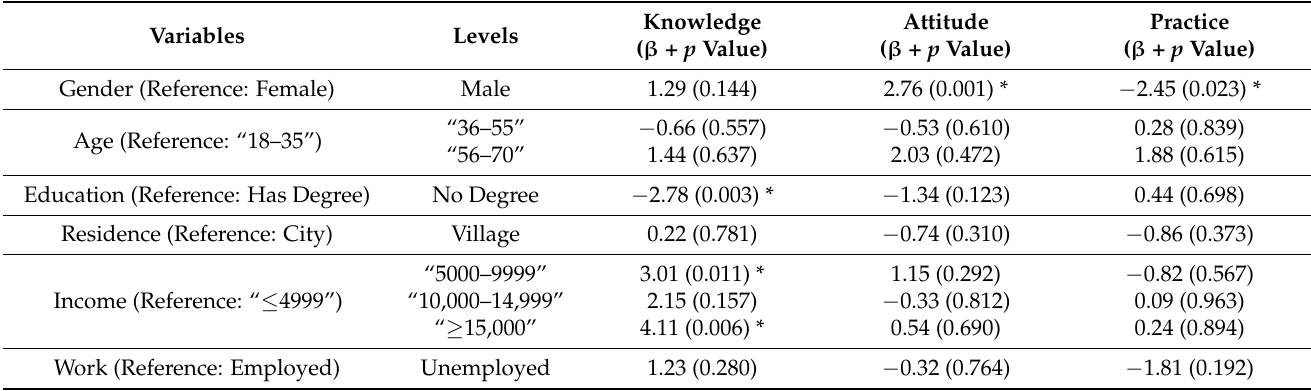
Table 3. Linear regression analysis of the association between the KAP scores and sociodemographic